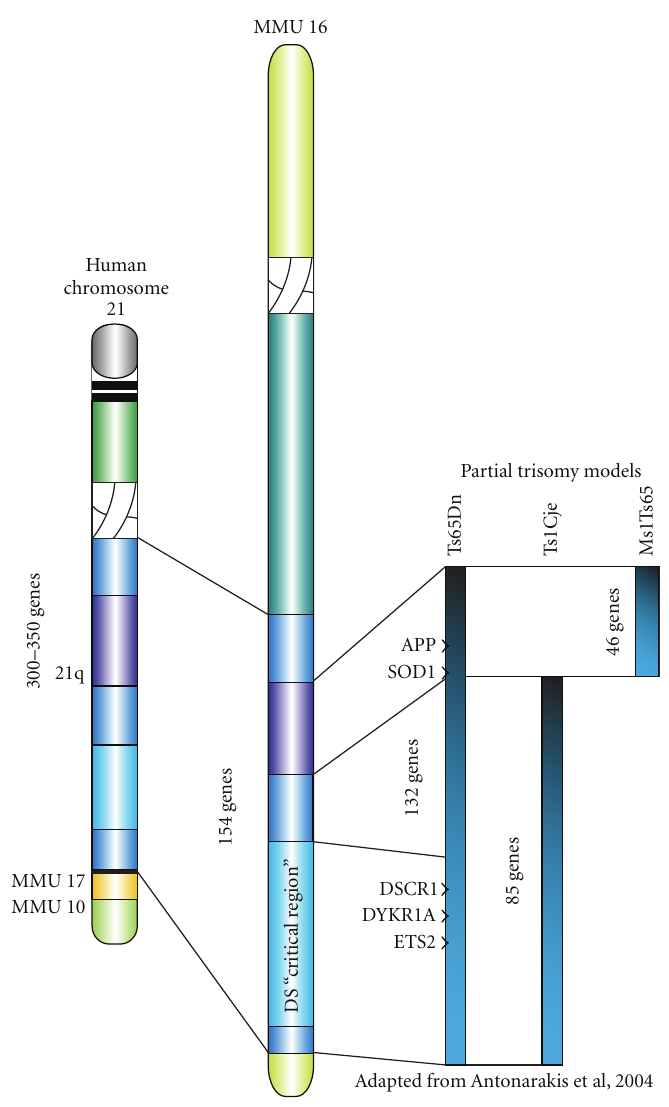
Figure 1: Mouse models for DS. Schematic of the gene segments involved in the so-called “Down syndrome critical region” (DSCR) in human chromosome 21, as well as in di ff erent mouse models of the condition. Note that the Ts65Dn mouse contains all genes included in the DSCR, as well as a set of 132 other genes including SOD and APP . Modified from Antonarakis et al. 2004 [21].